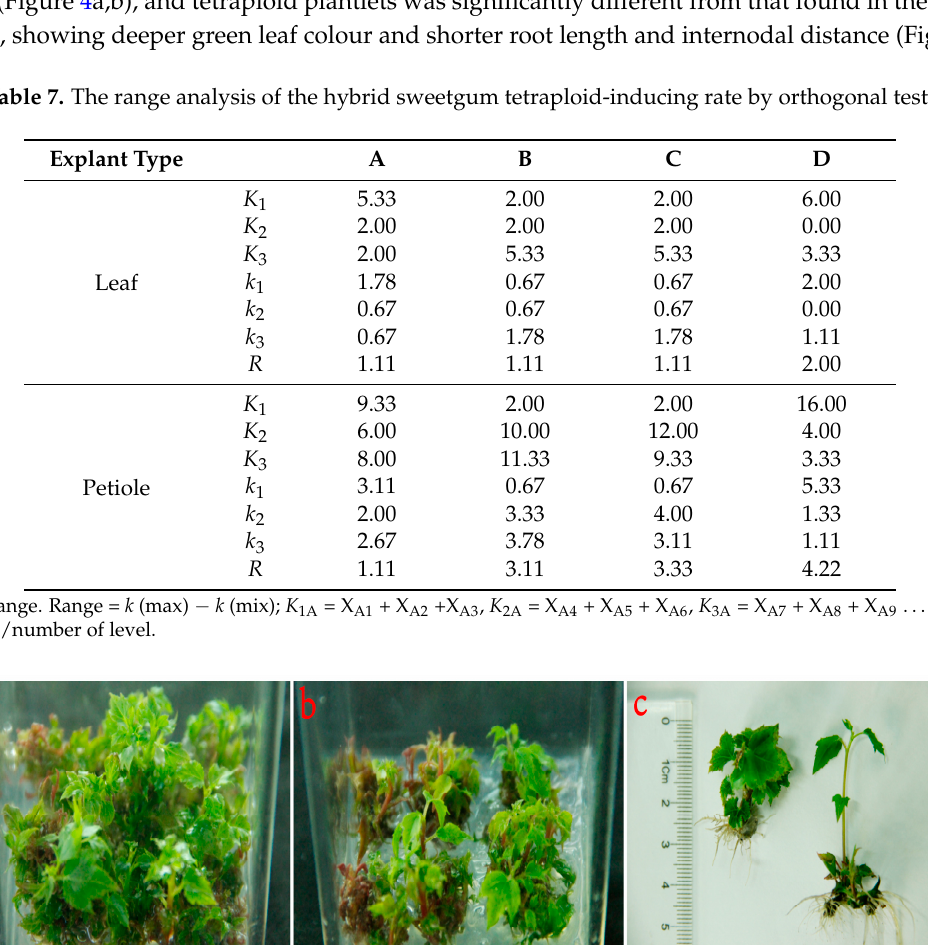
Table 7. The range analysis of the hybrid sweetgum tetraploid-inducing rate by orthogonal test.